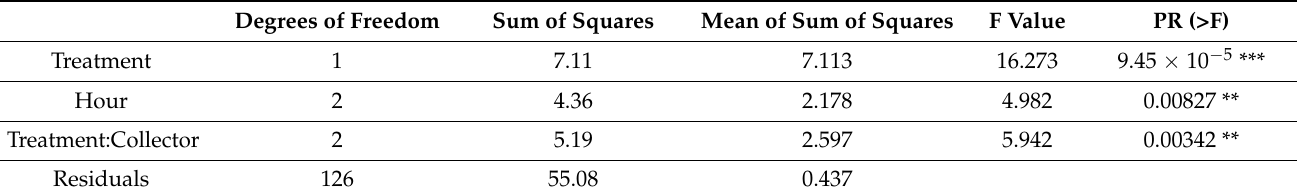
Table A10. Collector-Treatment Analysis.